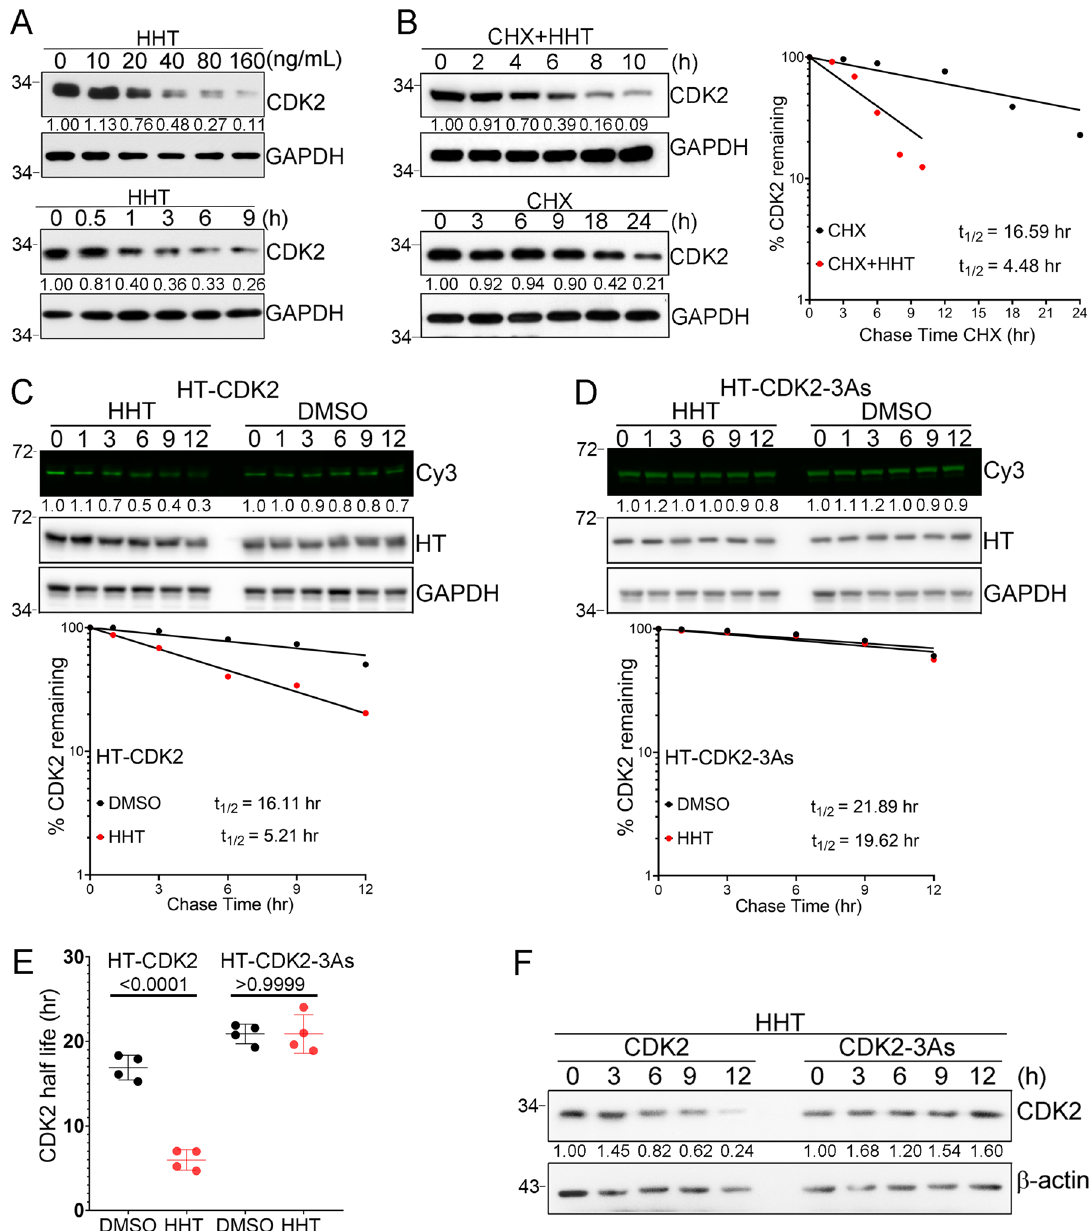
Fig. 3 CDK2 protein degradation in cancer cells induced by HHT treatment. A Representative western blots for CDK2 and GAPDH protein levels with HHT treatment. B THP1 cells were treated with either CHX (50 μ M) alone or CHX plus HHT (40 ng/mL) for the indicated times. The CDK2 and GAPDH protein levels were analyzed by western blot (left panel). CDK2 levels were quanti fi ed relative to GAPDH levels and graphed as the percent CDK2 protein remaining after treatment (right panel). Half-lives of CDK2 and CDK2-3As were calculated from exponential line equations and shown as indicated. C Pulse-chase analysis of exogenous CDK2 protein using HT-TMR system in 293T cells transfected with HT-CDK2. After labeled with HT-TMR ligand, the cells were treated with 50 ng/ml of HHT for indicated time and subjected to the following experiment. The HT-TMR ligand-labeled HT-CDK2 was visualized with a fl uoro-image analyzer (upper panel) and the total expression of HT-CDK2 was analyzed by western blot with GAPDH as the loading control. The relative amount of HT-TMR ligand-labeled HT-CDK2 was measured with densitometric intensity of each band (lower panel). D Pulse-chase analysis of exogenous CDK2-3As protein using HT-TMR system in 293T cells transfected with HT-CDK2-3As. After labeled with HT-TMR ligand, the cells were treated with 50 ng/ml of HHT for indicated time and subjected to the following experiment. The HT-TMR ligand-labeled HT-CDK2-3As was visualized with a fl uoro-image analyzer (upper panel) and the total expression of HT-CDK2-3As was analyzed by western blot with GAPDH as the loading control. The relative amount of HT-TMR ligand-labeled HT-CDK2-3As was measured with densitometric intensity of each band (lower panel). E Summary of exogenous CDK2 and CDK2-3As half-lives in THP-1 cells with or without HHT treatment. Data represent the mean ± SD from four independent biological samples for each group. P values are indicated by two-tailed unpaired Student ’ s t test. F Representative western blot of CDK2 and CDK2-3As protein levels in THP1 cells treated with HHT (40 ng/mL) for the indicated time. All the results shown here were representative of three independent experiments. Source data are provided as a Source data fi le.